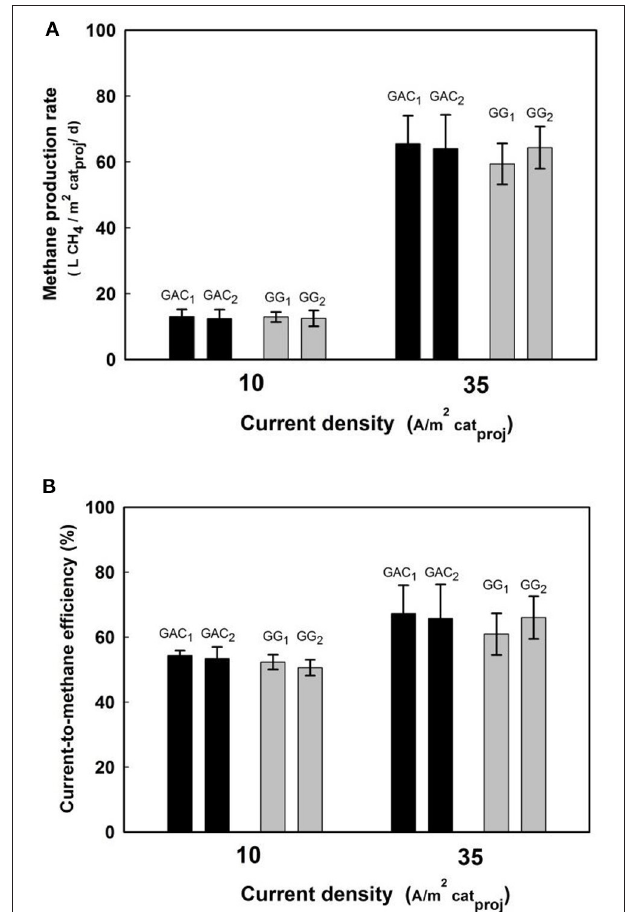
FIGURE 2 | Methane production rates (A) and current-to-methane efficiencies (B) at current densities of 10 A/m 2 cat proj and 35 A/m 2 cat proj for GAC and GG biocathodes. Data were collected throughout a period of 2 weeks with stable performance for every reactor. Shown are the average value and standard deviation of four samples for each reactor and current